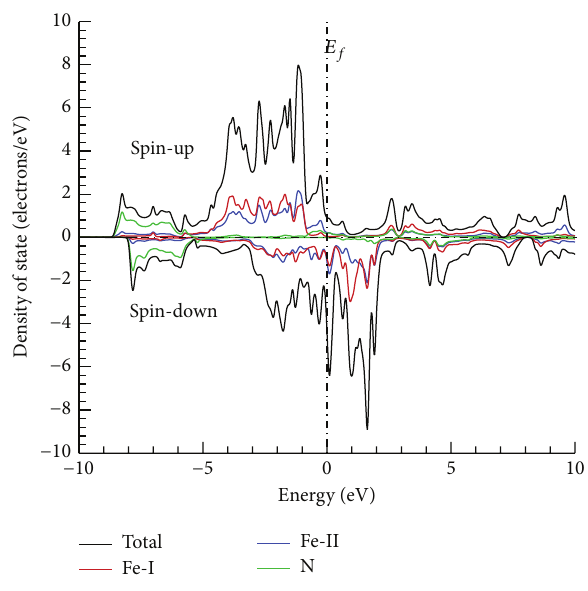
Figure 2: Total and partial density of state at 𝑎 = 3.772